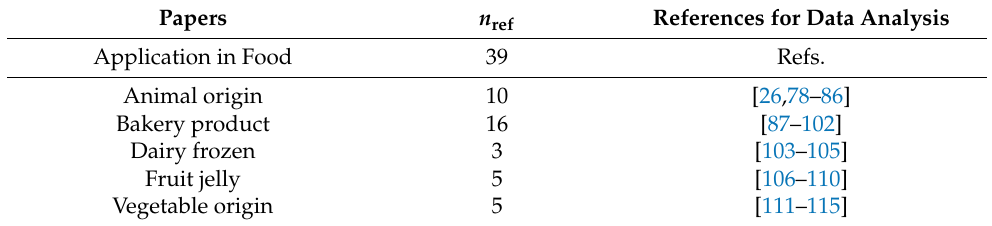
Table 3. Application of mixture design in